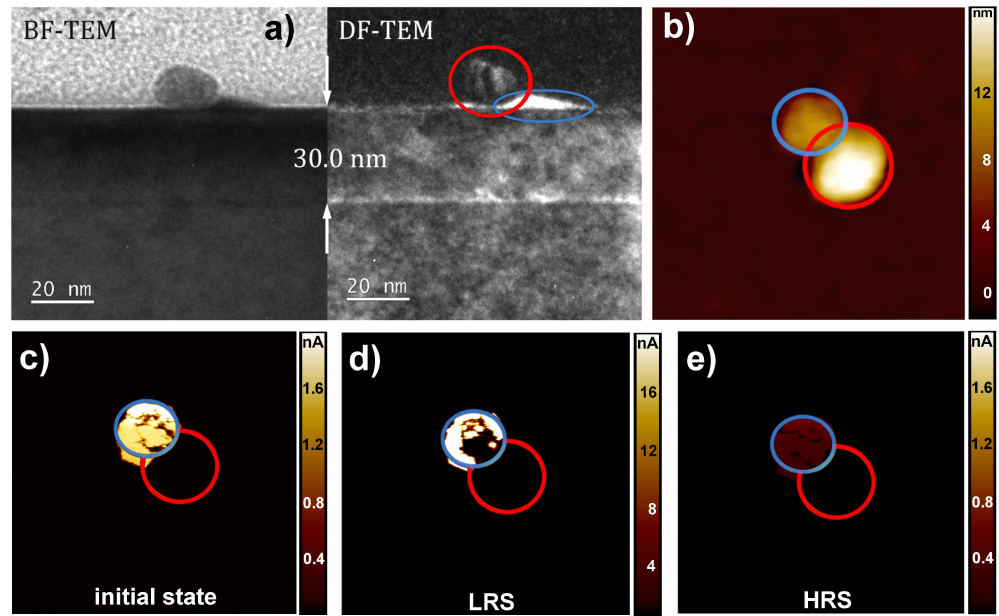
Figure 4. TypeII resistive switching at the distorted SrTiO 3 island next to the AuNP. ( a ) Bright field (BF) and dark field (DF) TEM images with distorted SrTiO 3 island (blue) and AuNP (red) on top of the 30-nm stoichiometric SrTiO 3 thin film (identical to Figure 2a). ( b ) Topography image of a 30-nm stoichiometric SrTiO 3 thin film deposited at 1.02J/cm 2 , containing both the distorted SrTiO 3 island and the AuNP. ( c – e ) Current images measured with a read out voltage of +0.5V in the same area as (b). For the initial (c), the LRS after (a) scan with +2V (d) and the HRS after a scan with − 2V (e). All LC-AFM images were taken with a scan size of 400nm ×